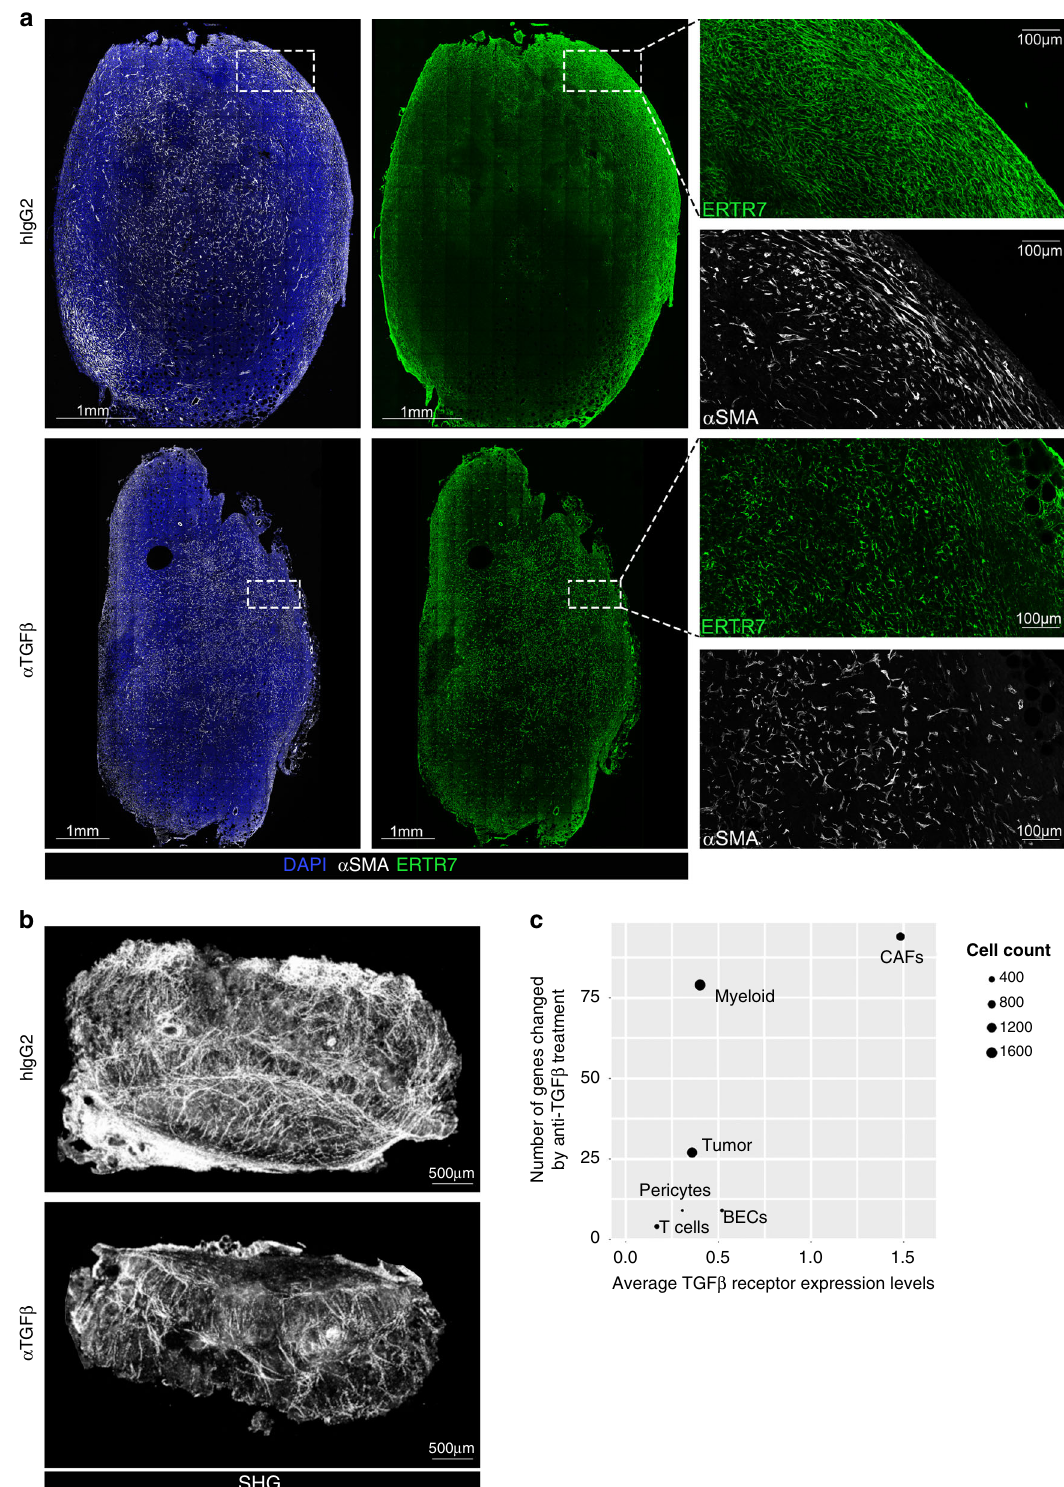
Fig. 3 TGF β -neutralization affects the tumor ECM architecture. a Cryopreserved 4T1 tumors were sectioned, stained with Dapi and antibodies against ERTR7 and α SMA, and subjected to confocal microscopic analysis. Insets show an enlargement of the boxed area. Images are representative of 6 samples from two independent experiments. b Collagen fi bers were visualized with second-harmonic imaging microscopy. c Analysis of the magnitude of the transcriptional changes induced by anti-TGF β treatment in vivo on cell populations identi fi ed in 4T1 by single cell RNAseq, plotted against the overall TGF β receptor expression of each cell cluster. n = 4 mice per group from 2 independent